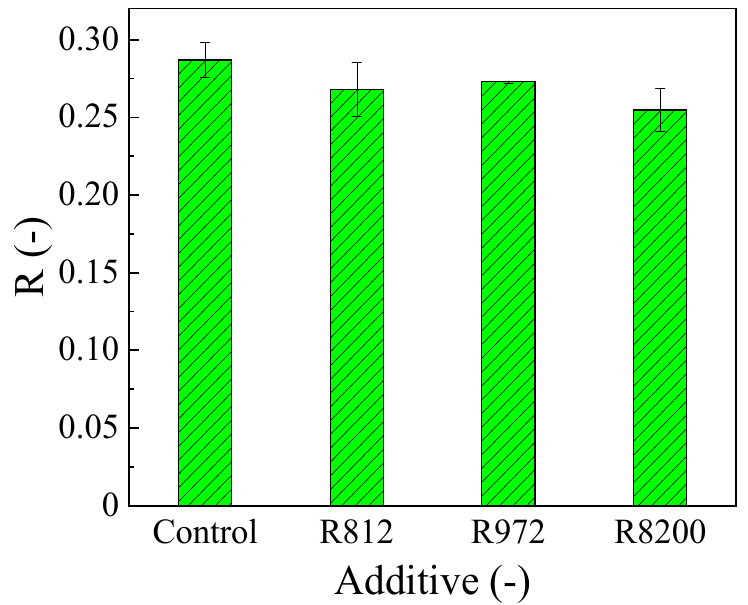
Figure 8. Faraday cage effect of powder samples.